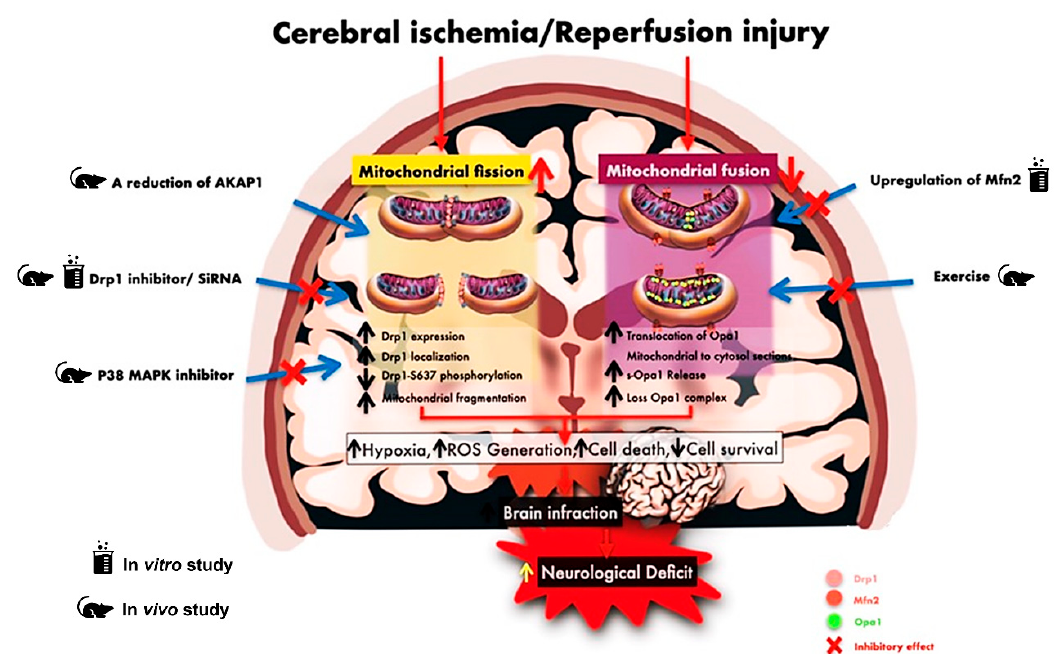
Figure 4. A summary of evidence in the interventions for the alterations in mitochondrial dynamics following ischemia/reperfusion: in vitro and in vivo studies. An increase in mitochondrial fission and a decrease in mitochondrial fusion were observed after cerebral ischemia/reperfusion. The upregulation of the Mfn2, exercise, inhibition of Drp1, and inhibition of P38 MAPK caused a decrease in mitochondrial fission, neuronal death, and neurological deficit. A reduction of AKAP1, which is an endogenous Drp1 inhibitor, increased mitochondrial fission, leading to an increase in brain infarct volume. AKAP-1, A-kinase anchoring protein 1; Drp1, dynamin-related protein-1; MAPK, major mitogen-activated protein kinases; Mfn2, mitofusin2; OPA1: optic atrophy protein1; s-OPA1, short optic atrophy protein1.